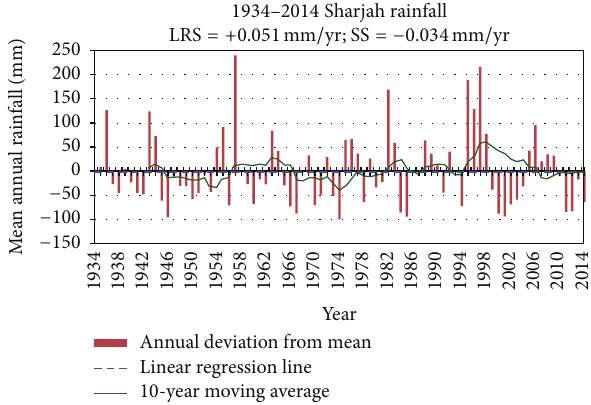
Figure 4: Deviation of annual rainfall from the mean and corre- sponding linear regression and 10-year moving average